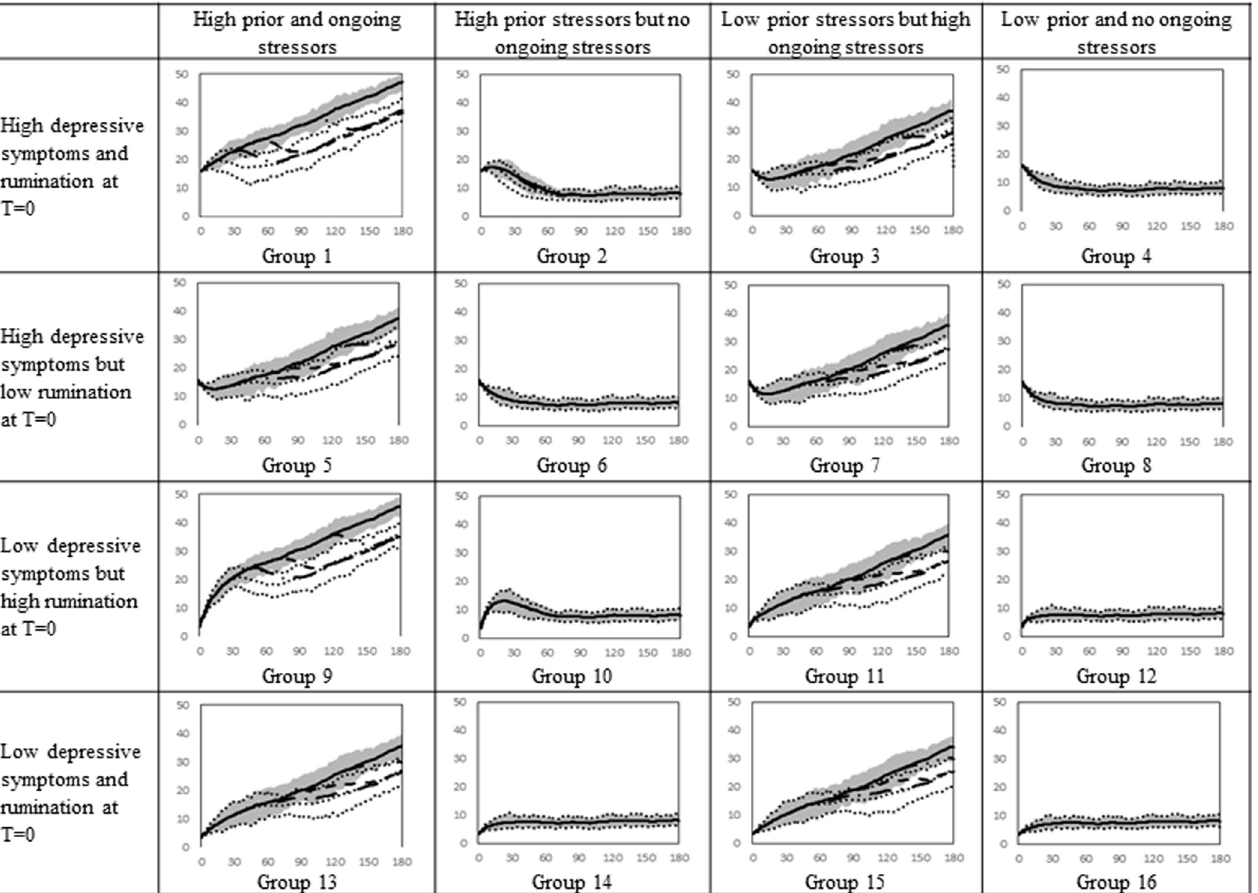
Fig 6. Simulated depressive symptoms for 16 female groups who receive therapy 6 months, 2 years, 4 years, and 8 years after their first episode. Solid line captures the baseline, the dot line, long-dash-dot, dashed line, and long-dash-dot-dot depict the depressive symptoms when girls receive therapy 6 months, 2 years, 4 years, and 8 years after their first